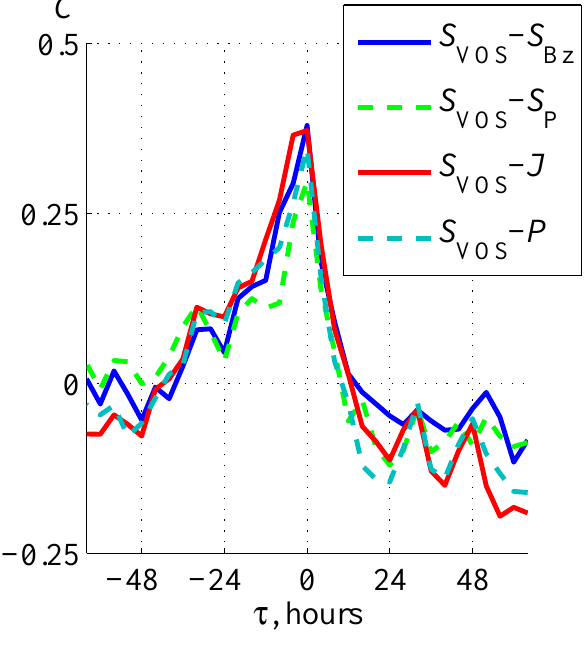
Fig. 8. Two year averaged S − V covariate functions C(τ) for var- ious stations. Only maximal and minimal covariate functions from auroral stations in the Northern Hemisphere are shown. Positive lag corresponds to S leading.